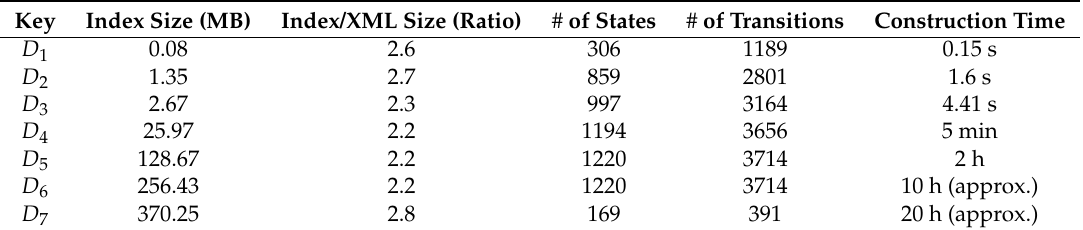
Table 5. Experimental results on the index size and construction